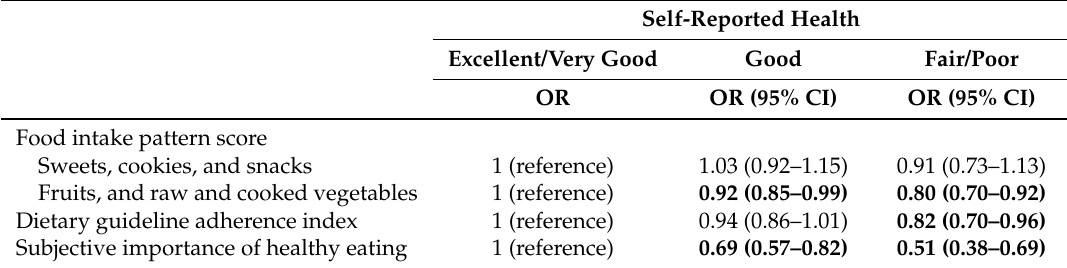
Table 4. Multinomial logistic regression of nutrition behaviours on self-reported health among undergraduates by gender, University of Turku, Finland,